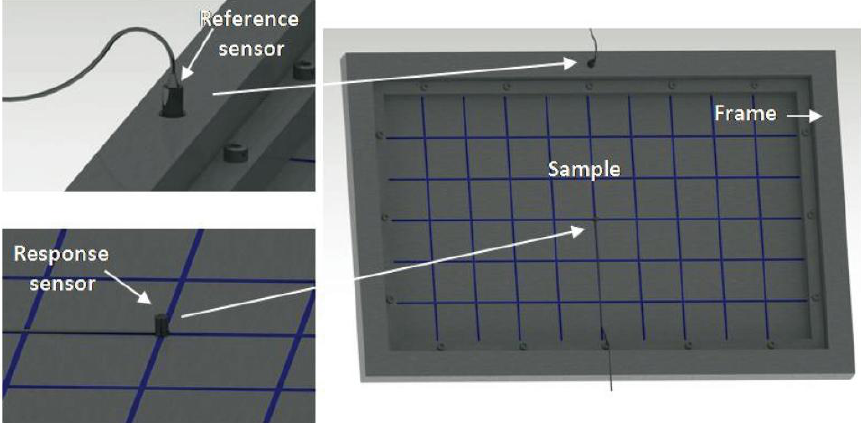
Figure 2. ODS measurements: measurement points, sensors and sample